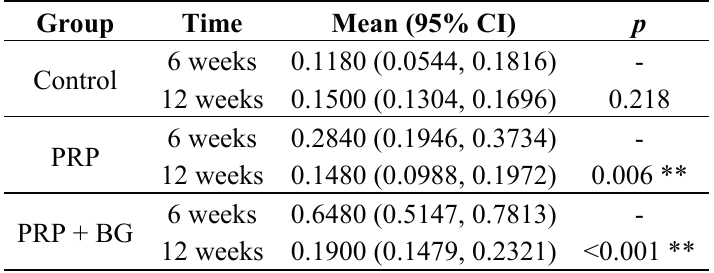
Table 4. T -test between different times in 3 groups